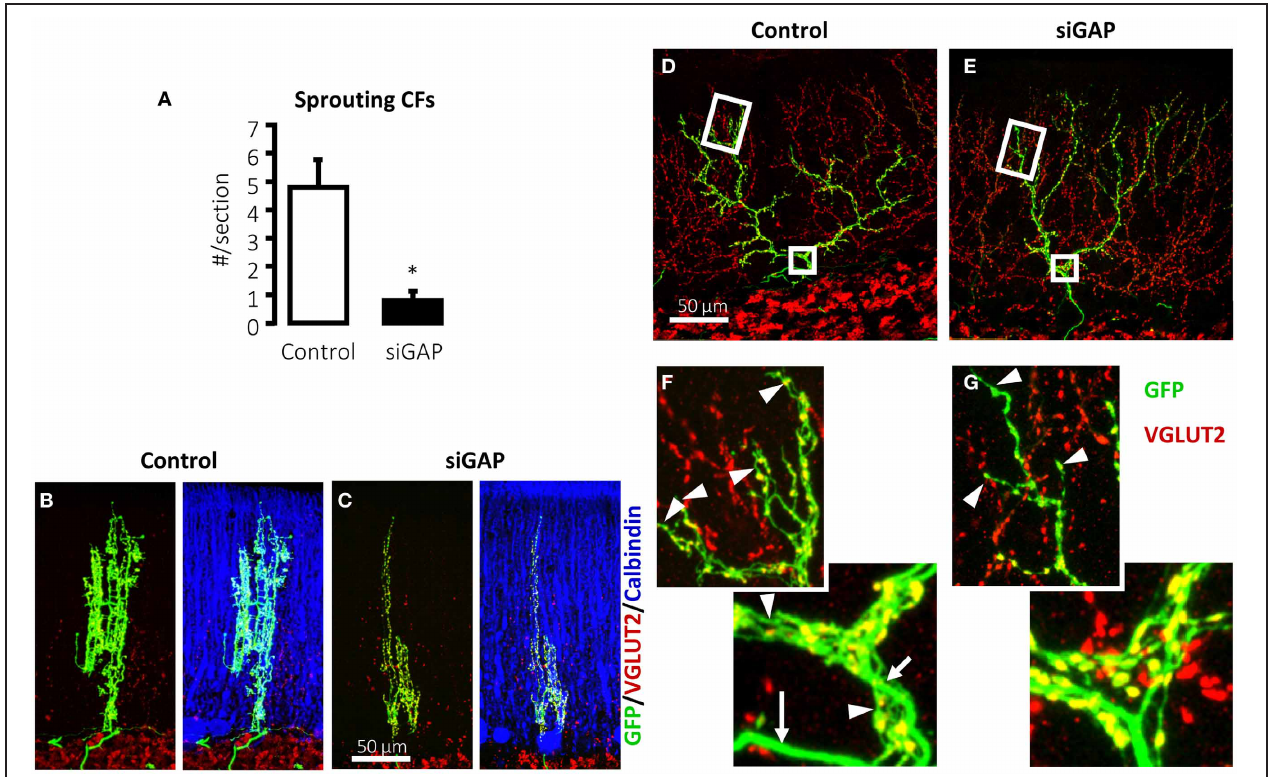
sections. (D,E) Representative confocal images of rat CFs in sagittal sections under normal conditions 3 weeks after treatment with control or silencing vectors. (F,G) Details of the most distal segment and first main branching point of CFs shown in (D,E) , showing a reduction in number and length of tendrils and consequent decrease in the density of varicosities. Arrows: thick axonal stalks; arrowheads: examples of tendrils [GFP, green; VGLUT2, red; calbindin, blue; modified from Grasselli et al.